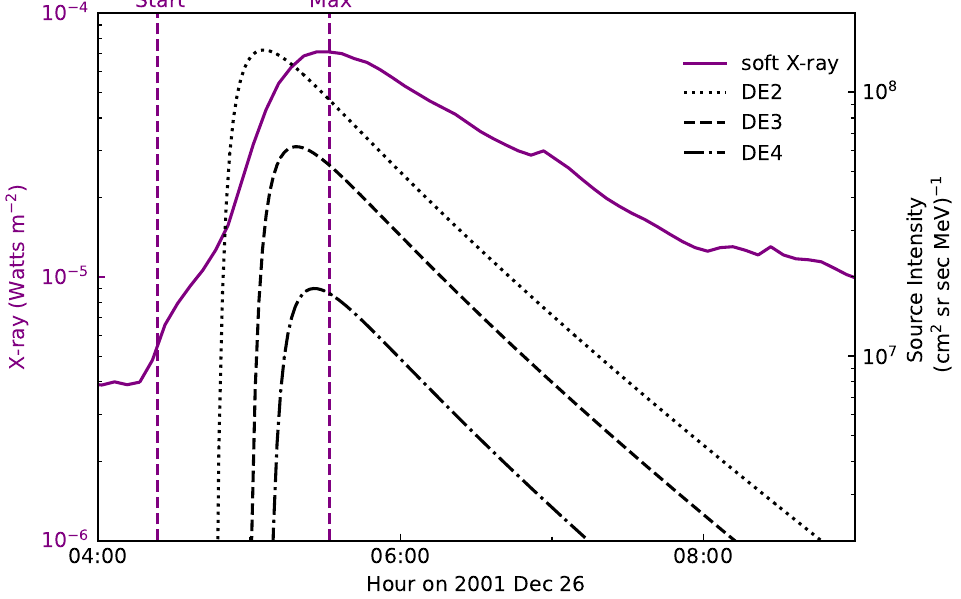
Figure 9. The particle source profiles in DE2–DE4 and associated SXR flare for the 26 Decemeber 2001 SEP event (similar as Figure 5).